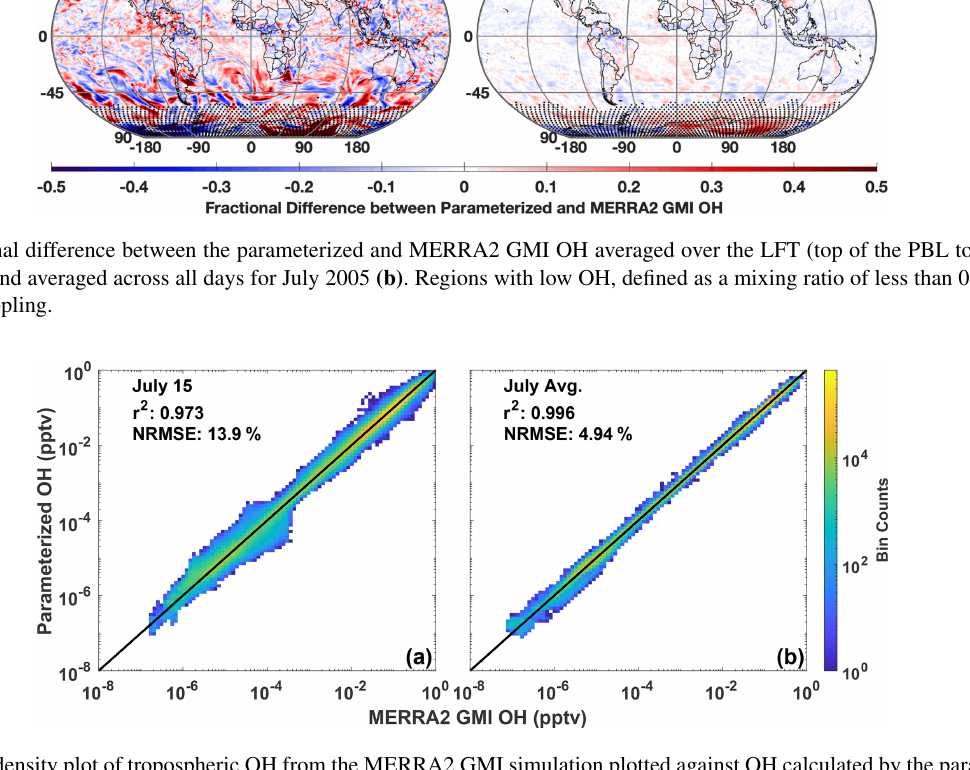
Figure 2. Scatter density plot of tropospheric OH from the MERRA2 GMI simulation plotted against OH calculated by the parameterization for 15 July 2005 (a) . Panel (b) shows the 24h averaged OH output by the parameterization averaged across all July days for 2005. Colors indicate the number of data points in each bin. The r 2 of a linear least-squares regression and the NRMSE are also